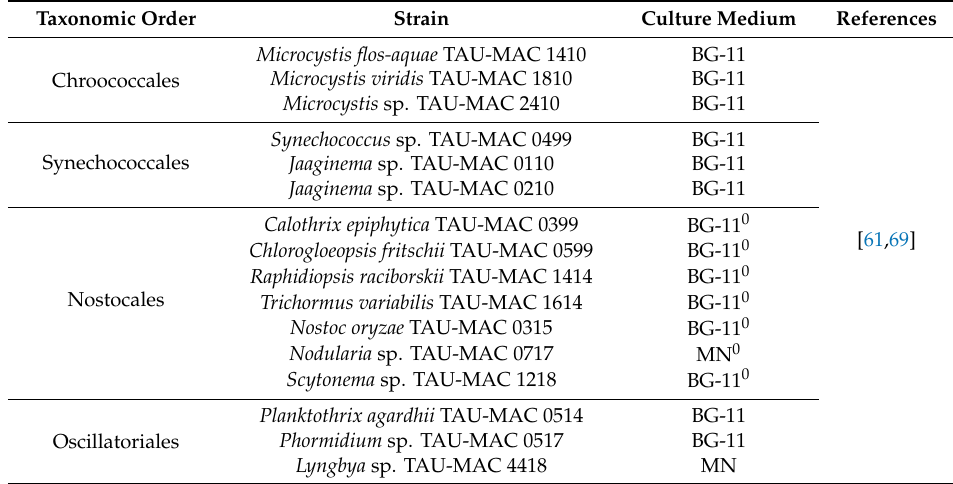
Table A1. The studied cyanobacterial strains: relevant information and media used for culture. “BG-11” and “MN”: contains NaNO 3 . “BG-11 0 ” and “MN 0 ”: no NaNO 3 added. For MN medium, 75% ( v / v ) seawater was used, according to